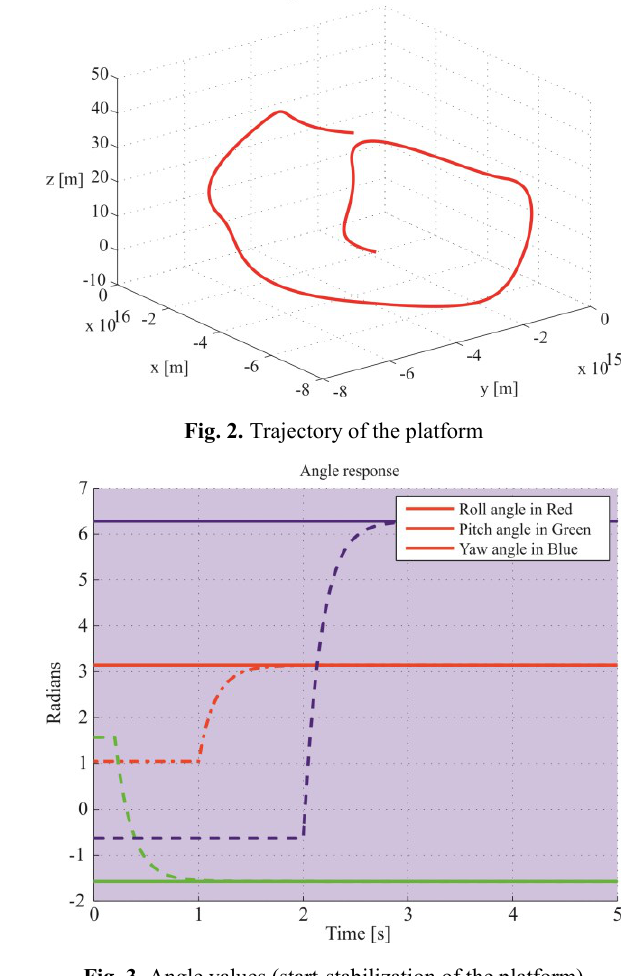
Fig. 3. Angle values (start-stabilization of the platform)